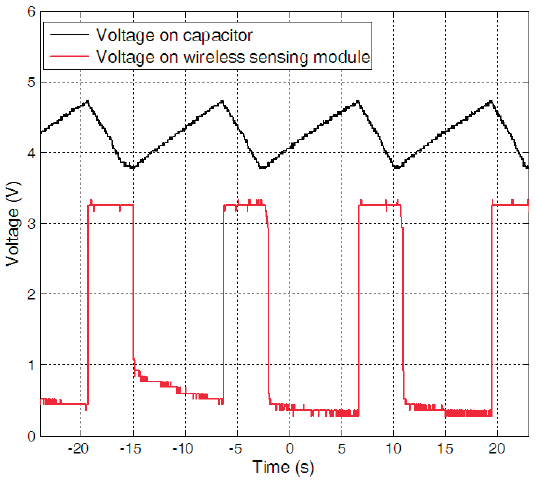
Figure 11. The duty time of the self-powered wireless sensor.